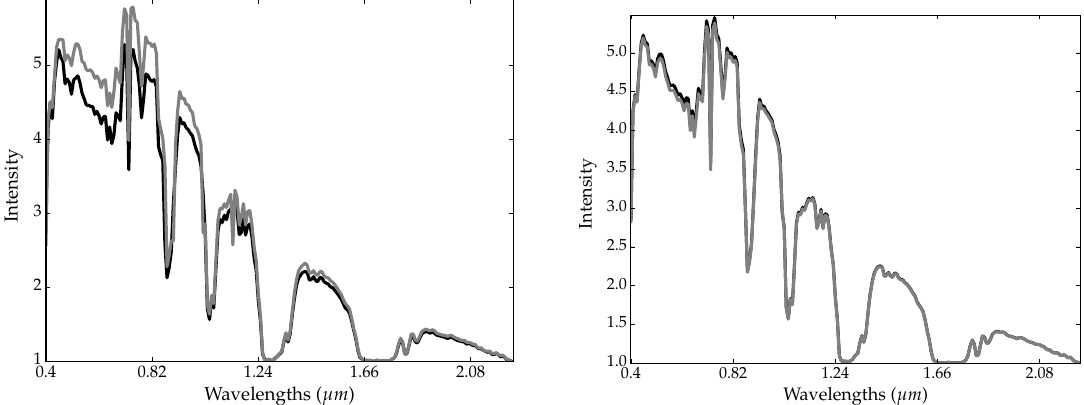
Figure 3. Effect of spatial smoothing on the spectra of two neighboring pixels: original image ( left ); image after spatial-smoothing ( right ). Spectra look more similar after spatial